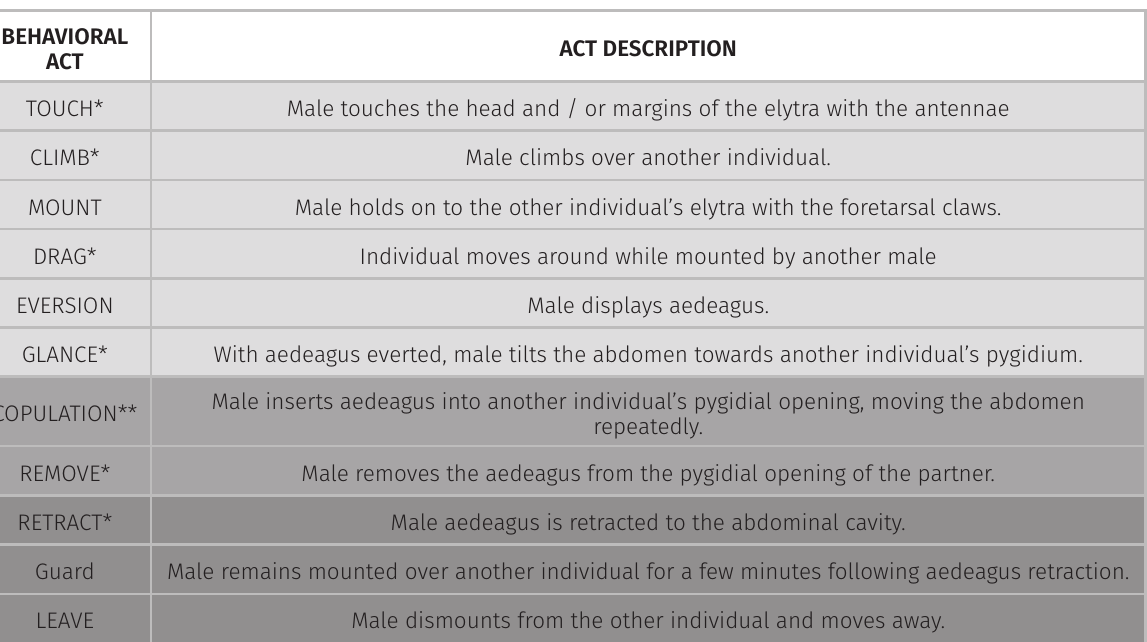
Table I. Simplified ethogram of the copulation repertoire of Cyclocephala distincta Burmeister 1847, adapted from original discriptions by Souza (2013) following experimental observations made in the